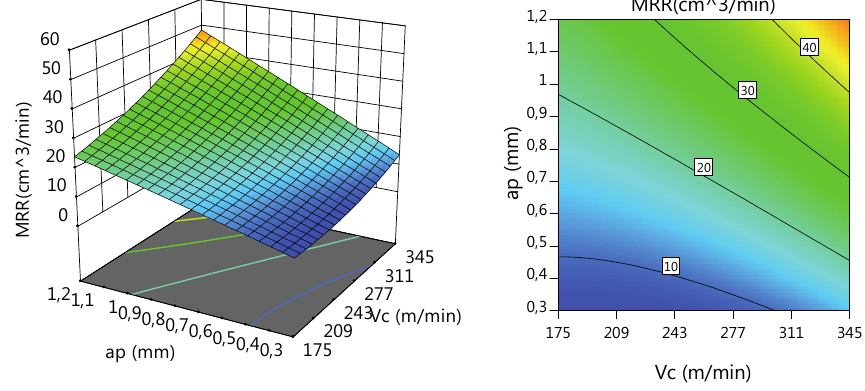
Fig. 24. Effect of cutting speed and depth of cut on material removal rate, with feed rate f=0.12mm/rev